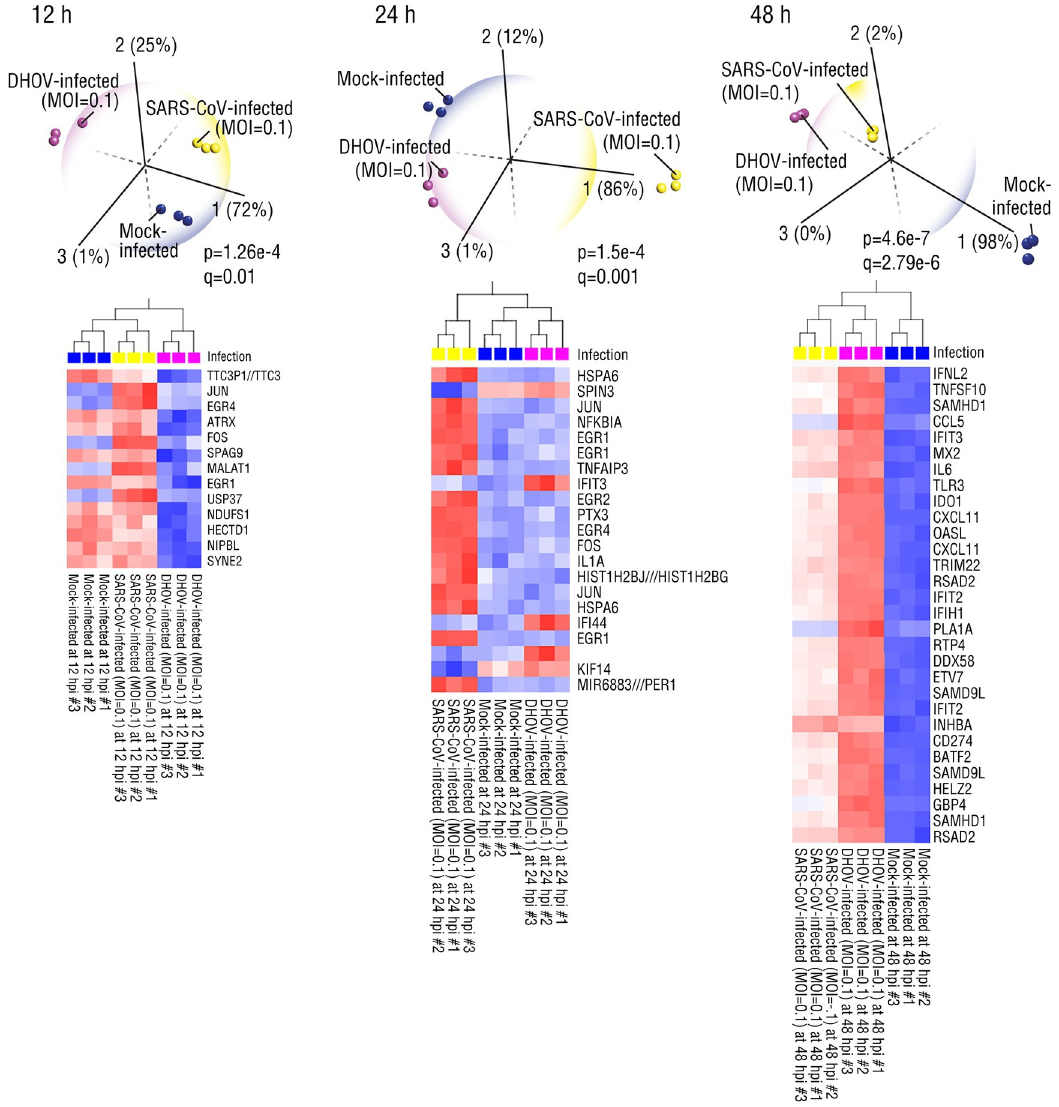
Fig 3. Dynamic temporal (12. 24, 48 hour) gene expression profiles distinguish coronavirus from Dhori virus-infected human bronchial epithelial (2B4) cells (GSE17400). Principal component and hierarchical clustering analyses of SARS-CoV-infected, Dhori virus- (DHOV) infected and Mock-infected Calu-3 cells shows that at each time point, the dynamic gene expression profiles, 1) discriminates virus-infected from Mock-infected cells, 2) distinguishes between the two virus infected groups from each other, and 3) identify discriminating genes that are involved in transcriptional regulation of the host immune response. Hpi = hours post infection, MOI = multiplicity of infection.